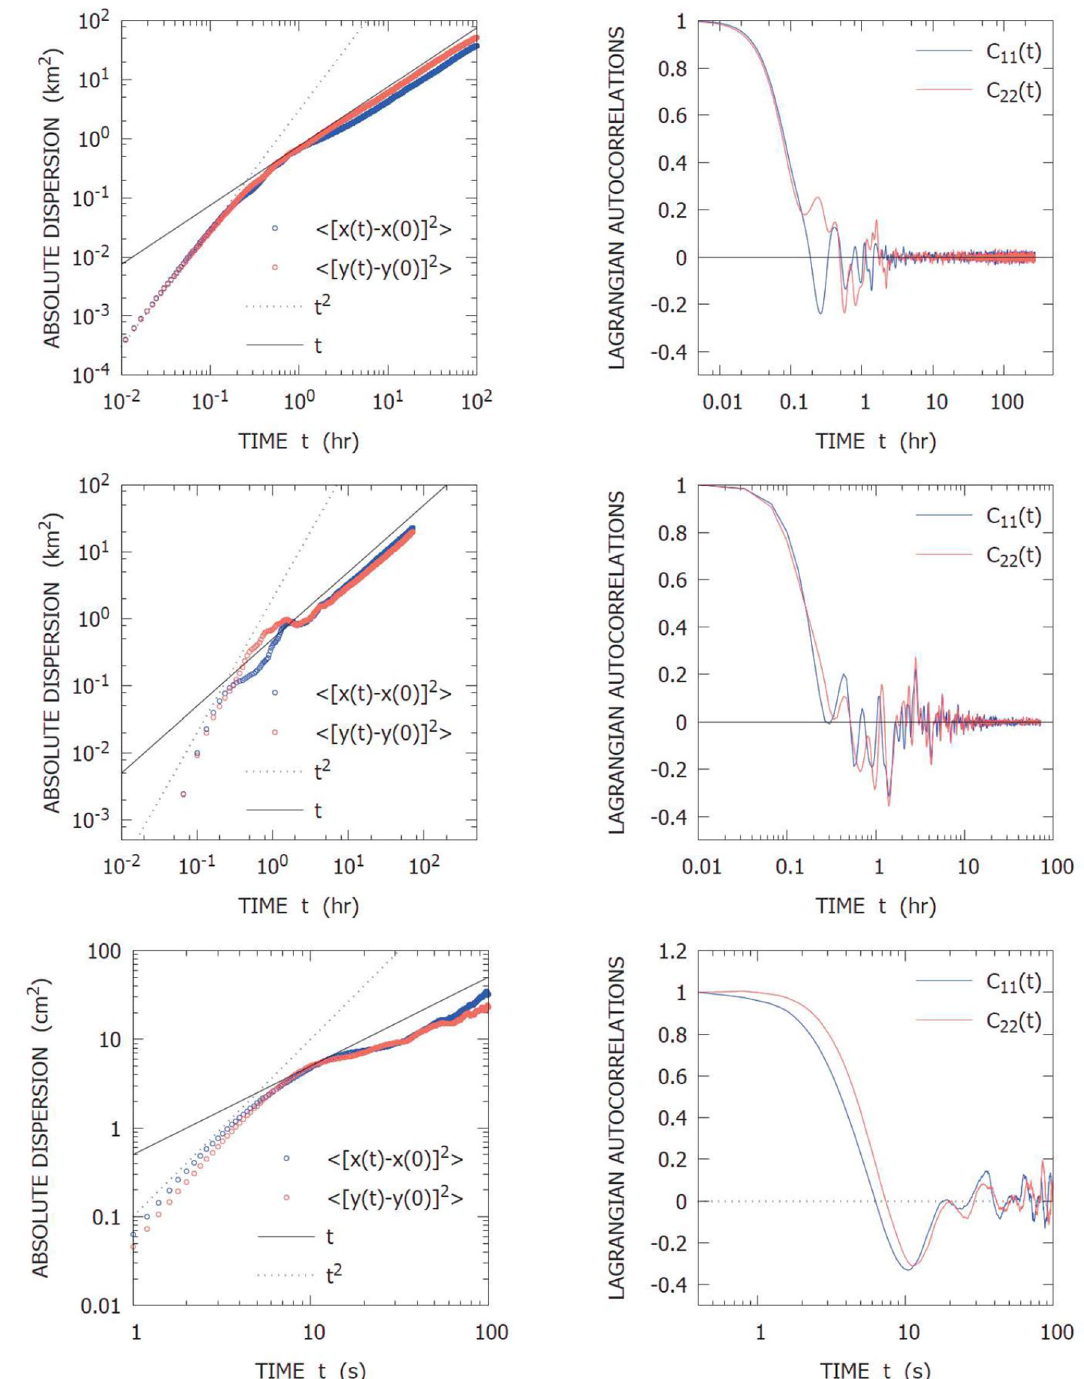
Figure 2. Single trajectory statistics: absolute dispersion and Lagrangian velocity autocorrelation for Kin2D (upper panel), Delft3D (center panel) and LabExp (lower